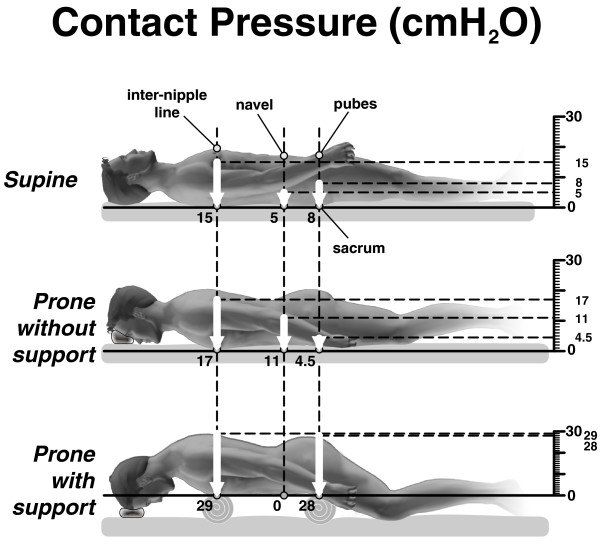
Patients' positions and contact pressures. Patients' positions used in the study: supine (top), prone without supports (center) and prone with thoraco-pelvic supports (bottom). The mean contact pressures (measured with pressure transducers in four healthy volunteers) are also indicated by white arrows. Table 2 shows detailed contact pressures at different sites and global values.